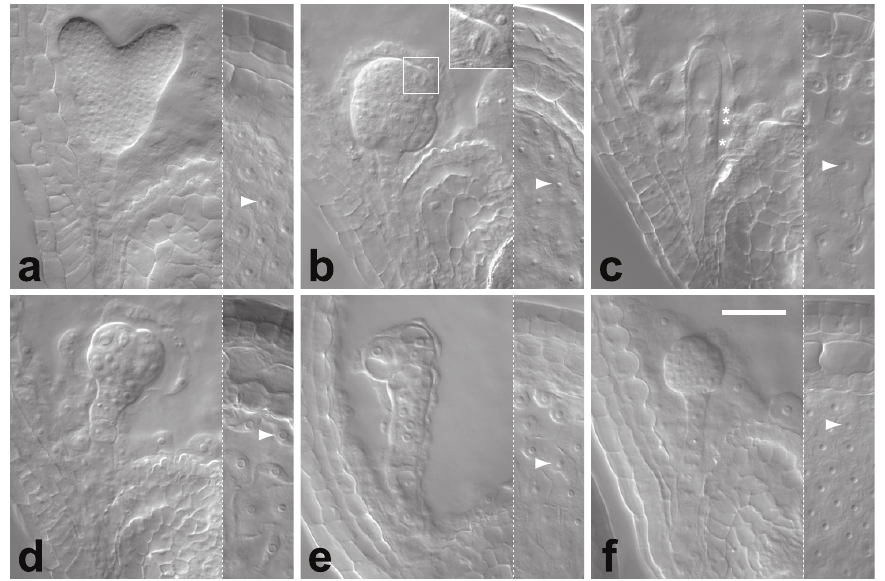
Fig 1. Range of cytokinesis-defective embryo phenotypes. Nomarski images of whole mount cleared immature seed; embryos at the heart stage of development are shown on the left and endosperm nuclei (arrowhead) on the right: ( a ) wild type; ( b ) kn mutant derived from line 4 – 43 (see text); enlarged cell caught in mitosis is boxed and shown magnified; ( c ) kn keu double mutant; three nuclei of normal size (stars) are visible; ( d ) phenotype produced by a weak kiesel allele; ( e ) double mutant phenotype produced by line 4 – 43; ( f ) mutant arrested at globular stage with no apparent cell division defects derived from line 4 – 43. Scale bar equals 50 μ